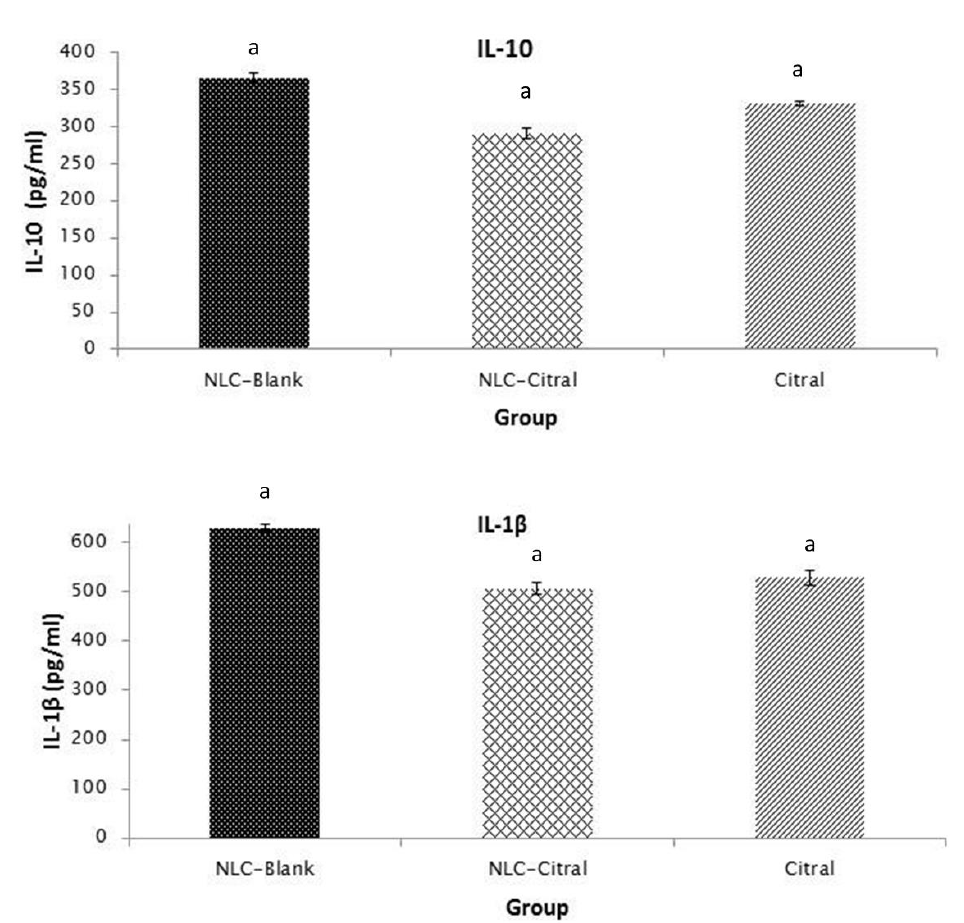
Figure A1. ELISA analysis of the concentration of (Upper) interleukin − 10 and (Lower) interleukin-1 β on blood serum of all mice. Each value in the bar charts is represented as mean ± SD, the experiment was performed in triplicate. Significance indicates by different alphabet was set at p < 0.05 comparing between groups.